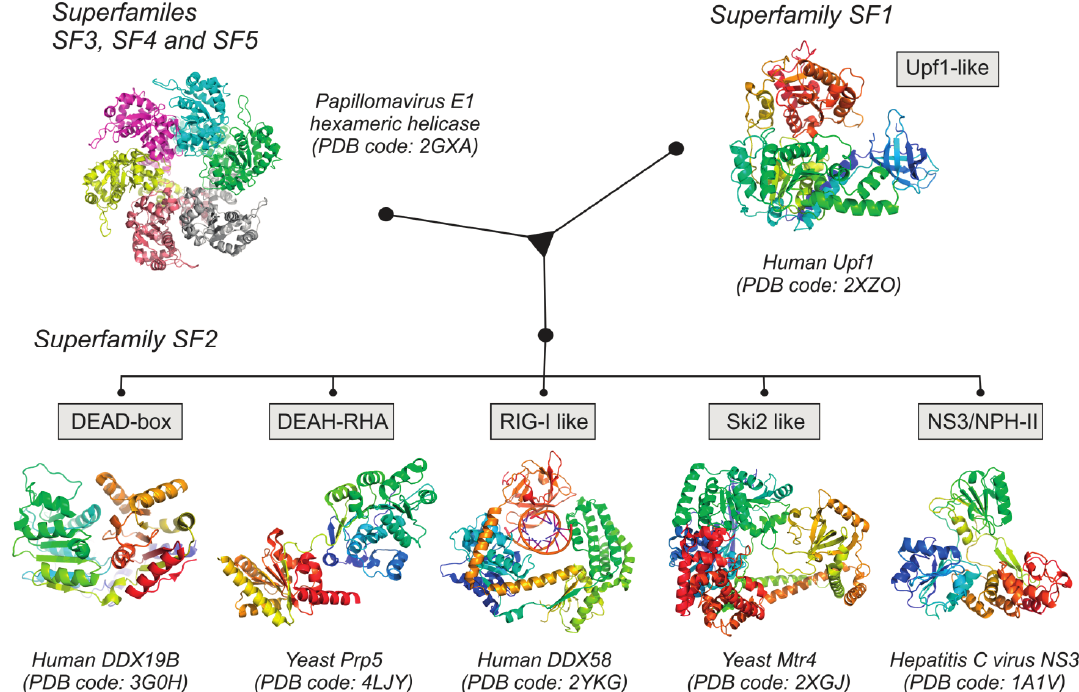
Figure 1. Structural families of RNA helicases, showing a representative Protein Data Bank (PDB) structure of each group. Superfamilies SF3, SF4 and SF5 are mainly hexameric helicases of viral origin. Superfamilies SF1 and SF2 are composed of monomeric proteins, found in all living organisms. RNA helicases belonging to SF2 are extremely diverse and can be sub-divided into five different classes, which only share the characteristic RNA-binding domain composed by RecA-like structural building